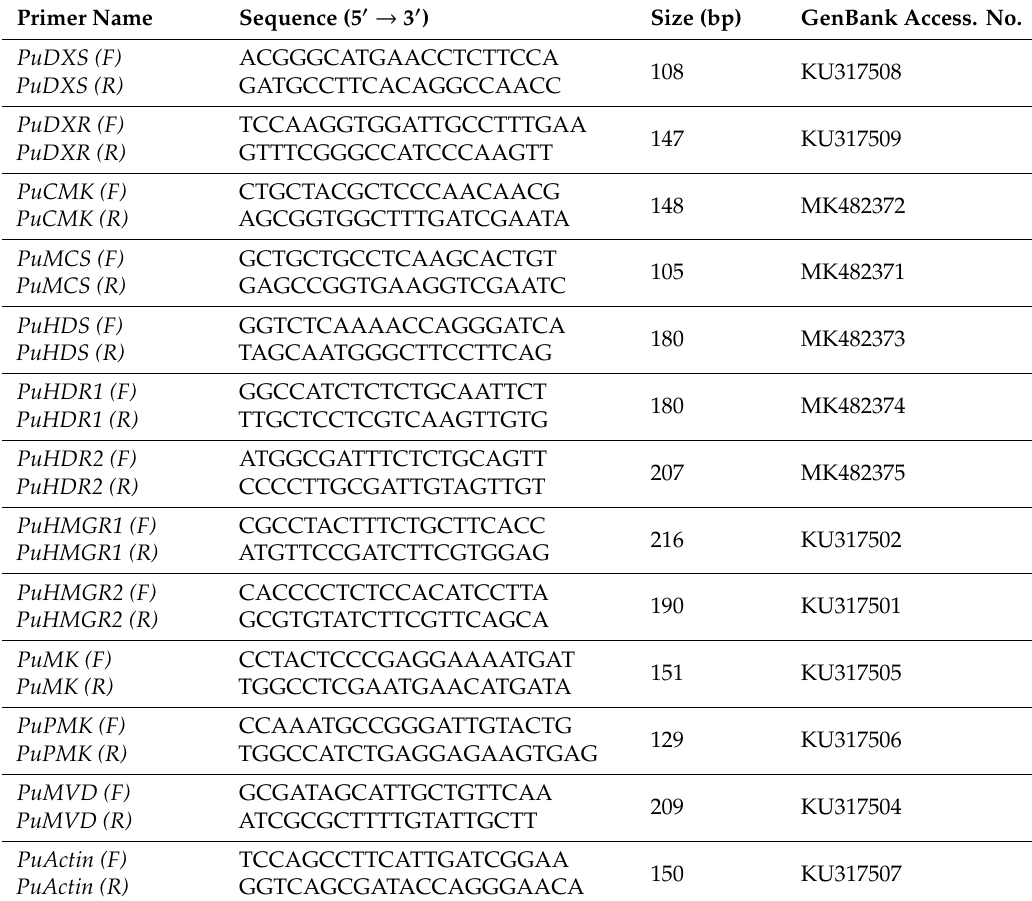
Table 1. Primers that were used in this